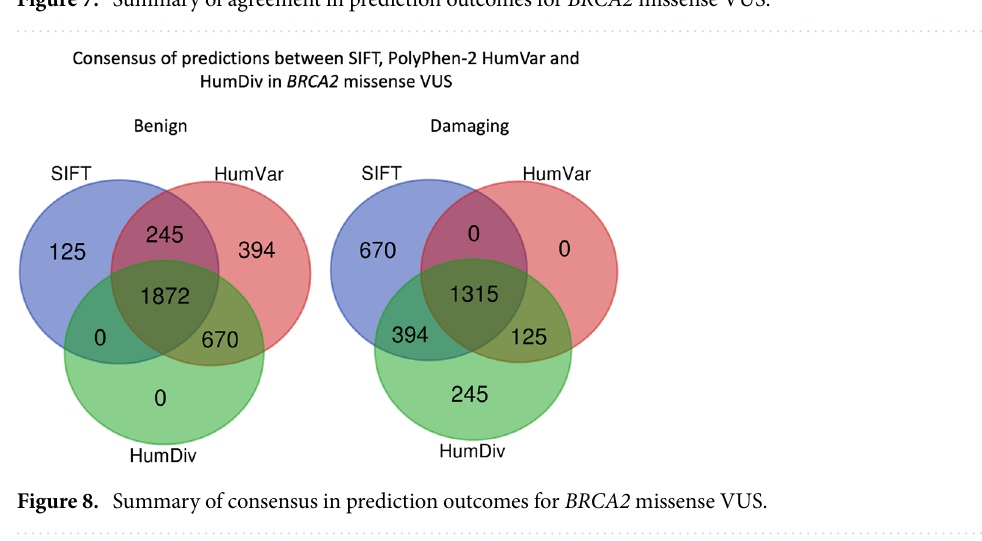
Figure 7. Summary of agreement in prediction outcomes for BRCA2 missense VUS.